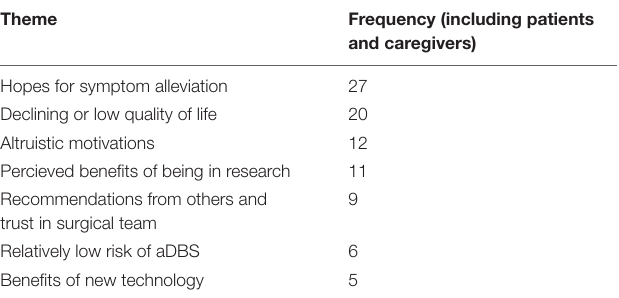
TABLE 4 | Relative frequency of themes for undergoing